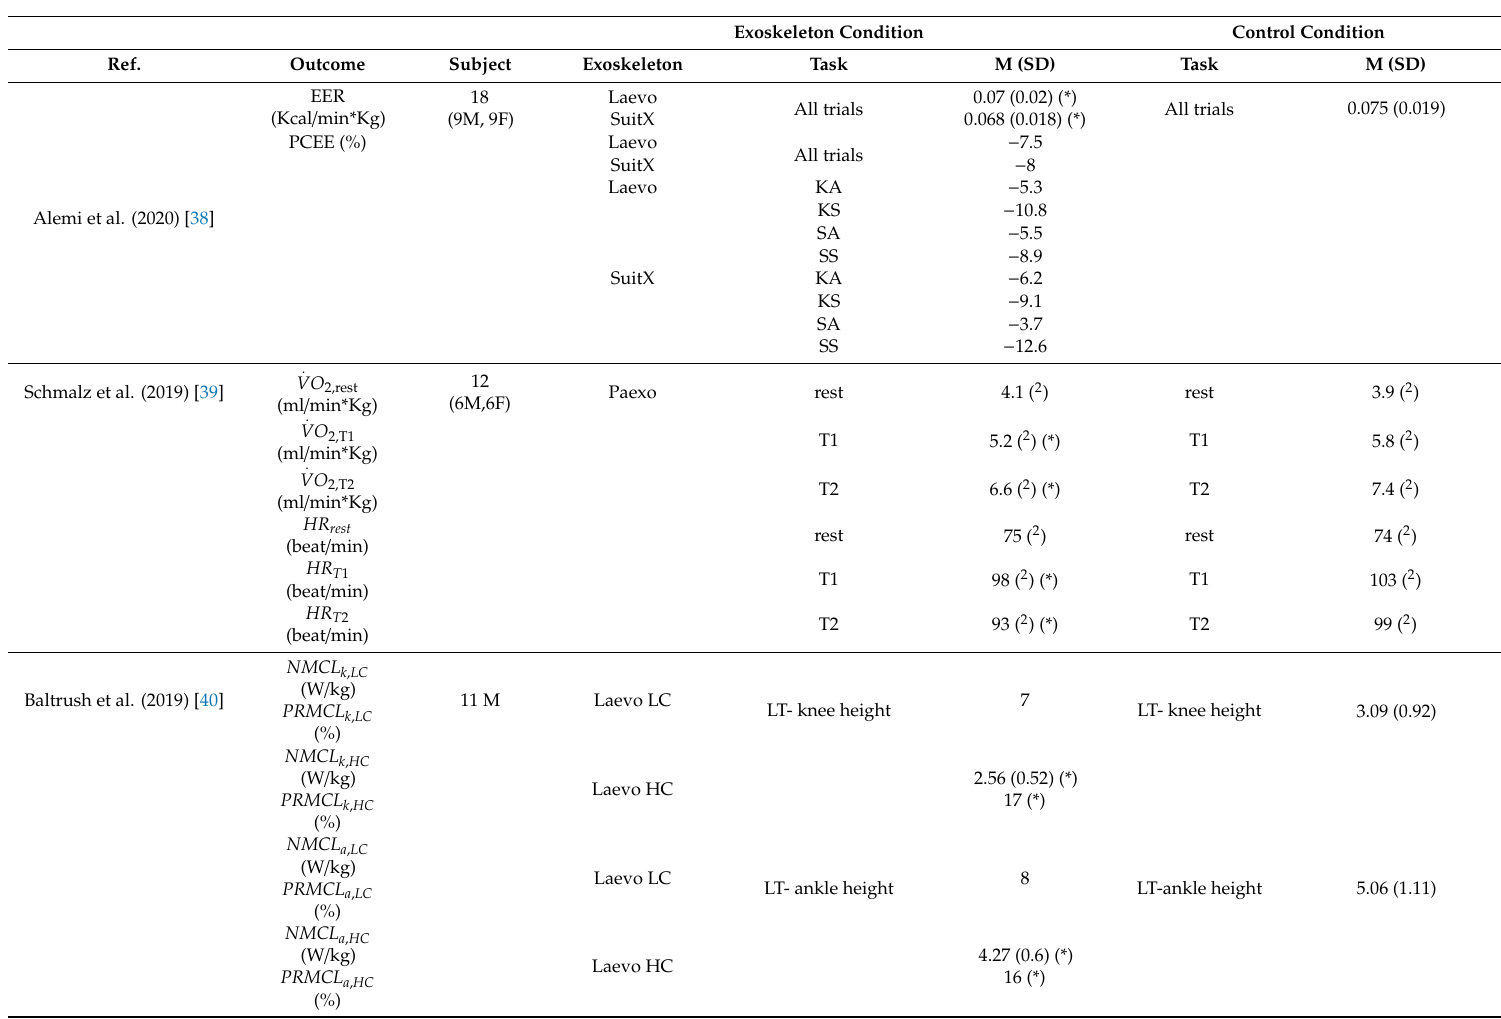
Table 3. The values of the outcome parameters of interest reported in the selected studies.